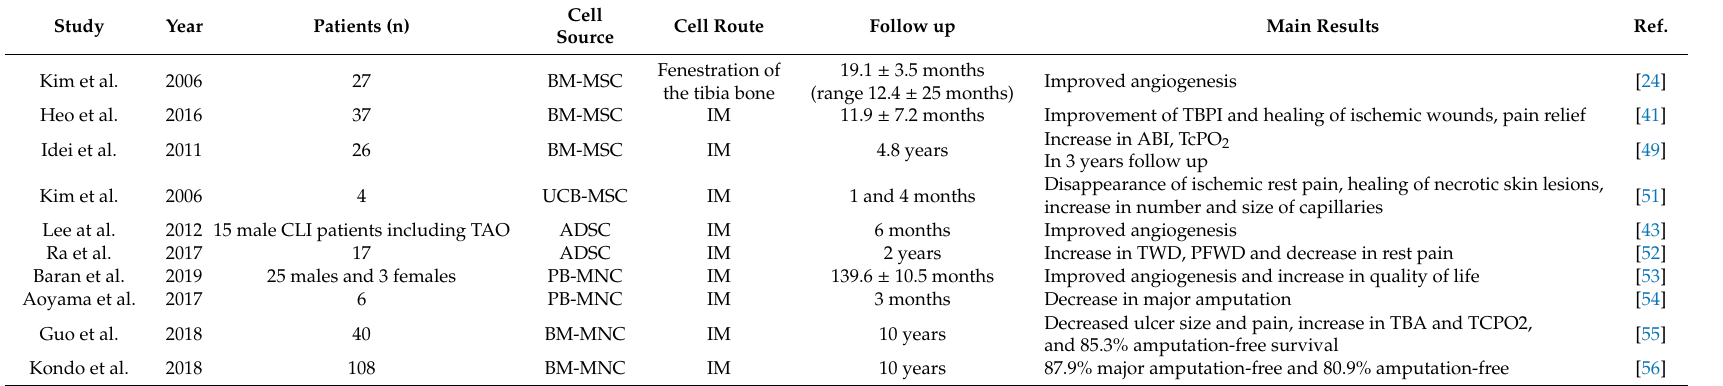
Table 1. Stem cell therapy clinical studies in TAO